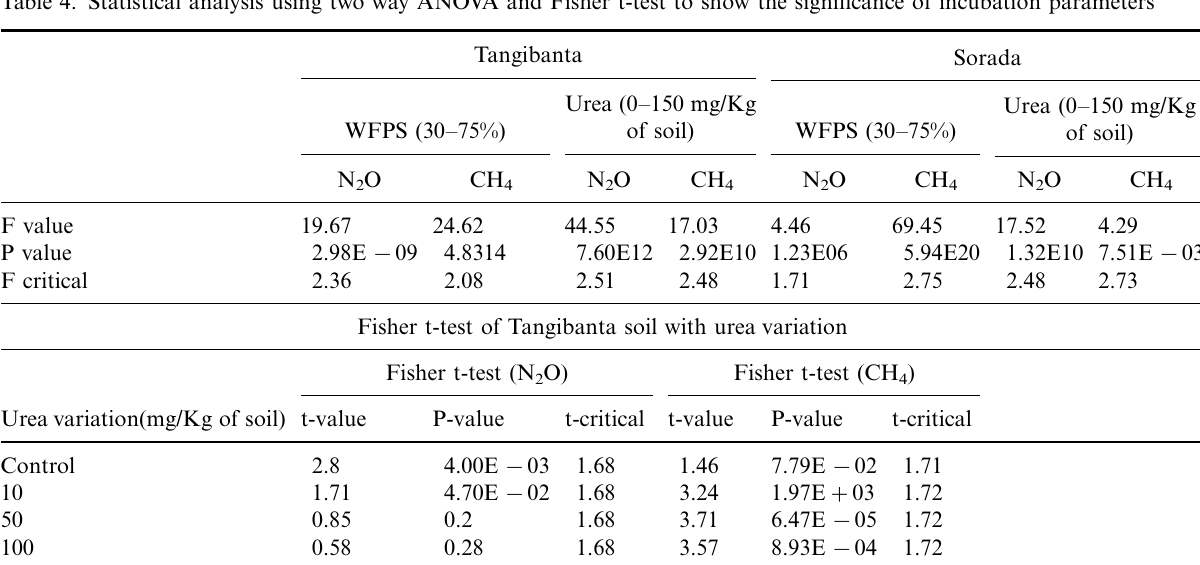
Table 4. Statistical analysis using two way ANOVA and Fisher t-test to show the significance of incubation parameters